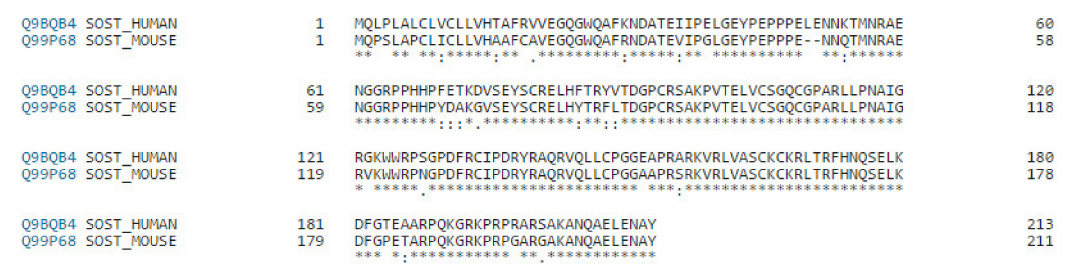
Figure 1. Amino acid sequence alignment of human and mouse sclerostin. Multiple sequence alignment was performed online by CLUSTAL Omega v.1.2.4 (http://www.clustal.org/omega/, accessed on 26 May 2017).